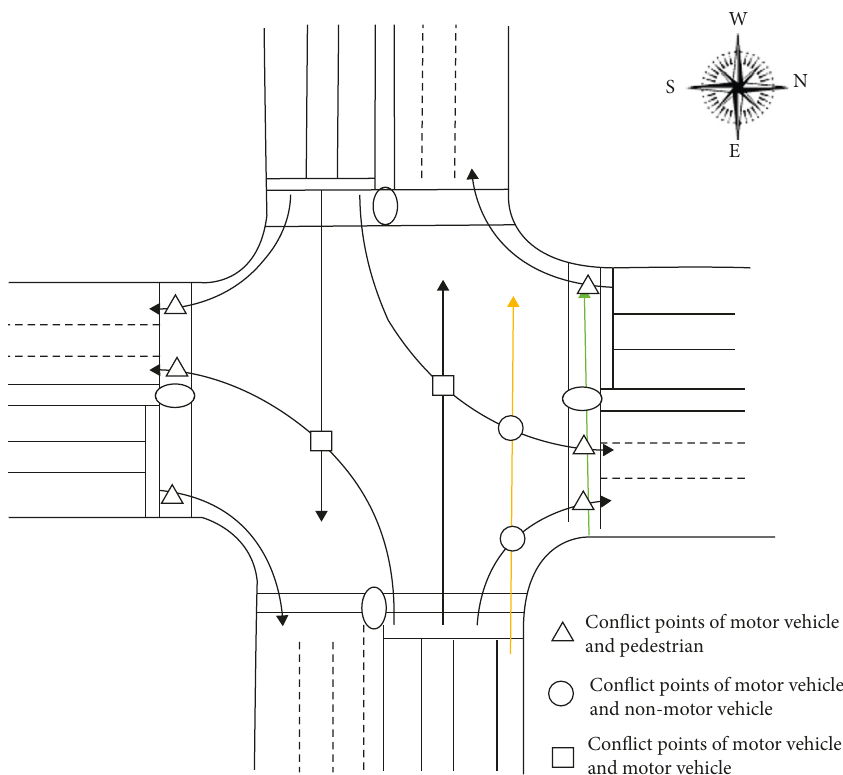
Figure 1: Diagram of internal conflict at intersection (take north-south direction as an